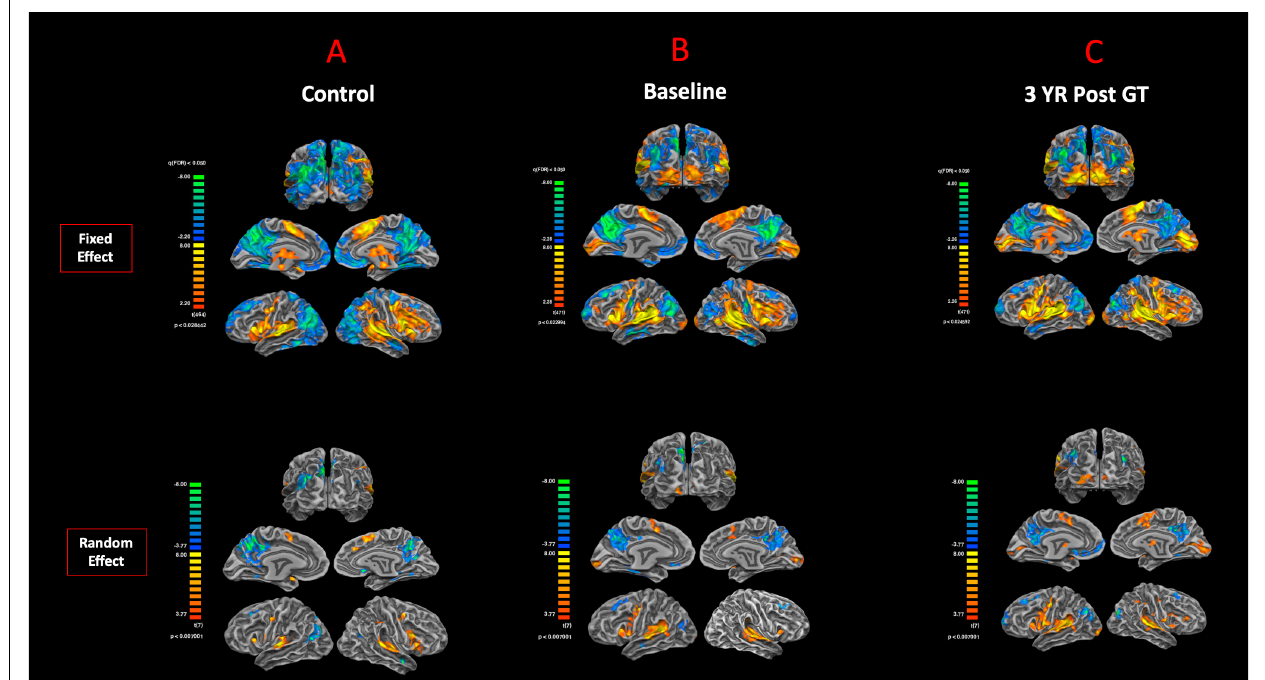
FIGURE 3 | Functional magnetic resonance imaging response to auditory stimulation. The results from the task-based auditory fMRI are presented for (A) sighted controls, (B) RPE65 patients before gene therapy, and (C) RPE65 patients 3 years after GT. The FX effect group analyses were processed at FDR corrected p < 0.02 ( q < 0.05), with an extent threshold of > 100 mm 2 , and the RFX analyses were performed at an uncorrected p < 0.007 with an extent threshold > 100 mm 2 . Sighted controls showed the expected cortical activations in and around the bilateral Heschl’s gyrus, the inferior frontal gyrus (IFG), and the somatosensory cortex and deactivations in the visual cortex and within the default mode network. Compared to sighted controls, baseline RPE65 patients had similar patterns of auditory cortical activation, yet significant cortical activations within the bilateral visual cortices. Three years after retinal gene therapy, RPE65 patients showed the similar cortical activation patterns that were significantly